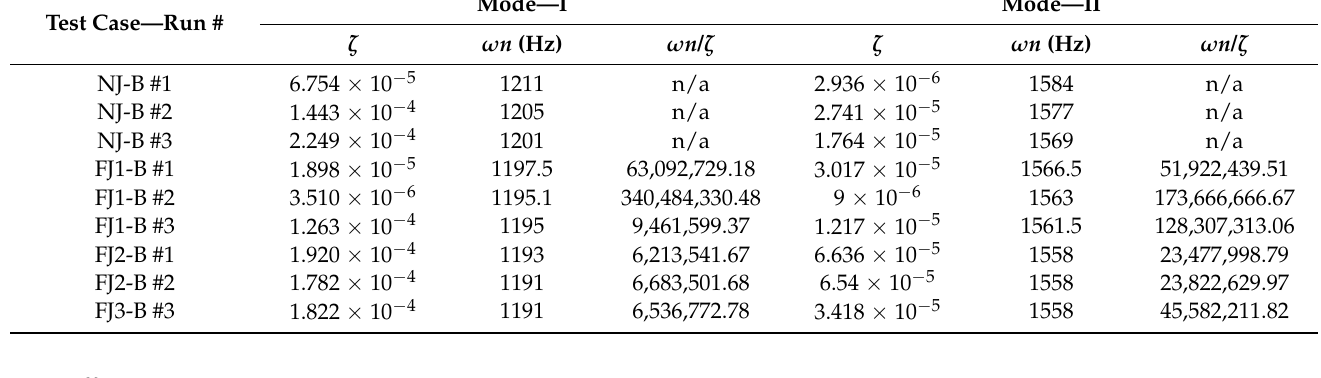
Table 2. Testing scenarios (at 80 Hz–600 mVpp) for detecting and identifying failing joints in structure-B.